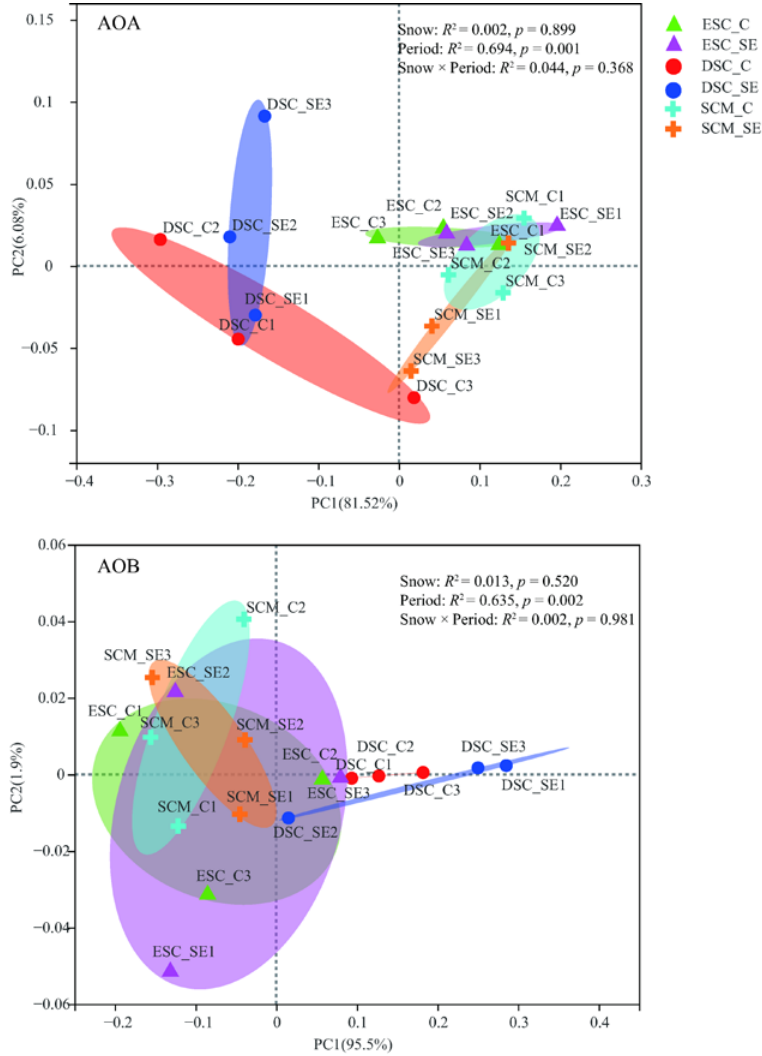
Figure 4. Principal coordinates analysis (PCoA) of soil AOA and AOB community composition (Bray–Curis distance) at phylum level between snow treatments and sampling periods. Different sampling periods are represented by different symbols. The diamond, circle, and cruciform represent the early snow cover (ESC), deep snow cover (DSC), and snow cover melting (SCM), respectively. The red represents Control (C), and the blue represents snow exclusion (SE).